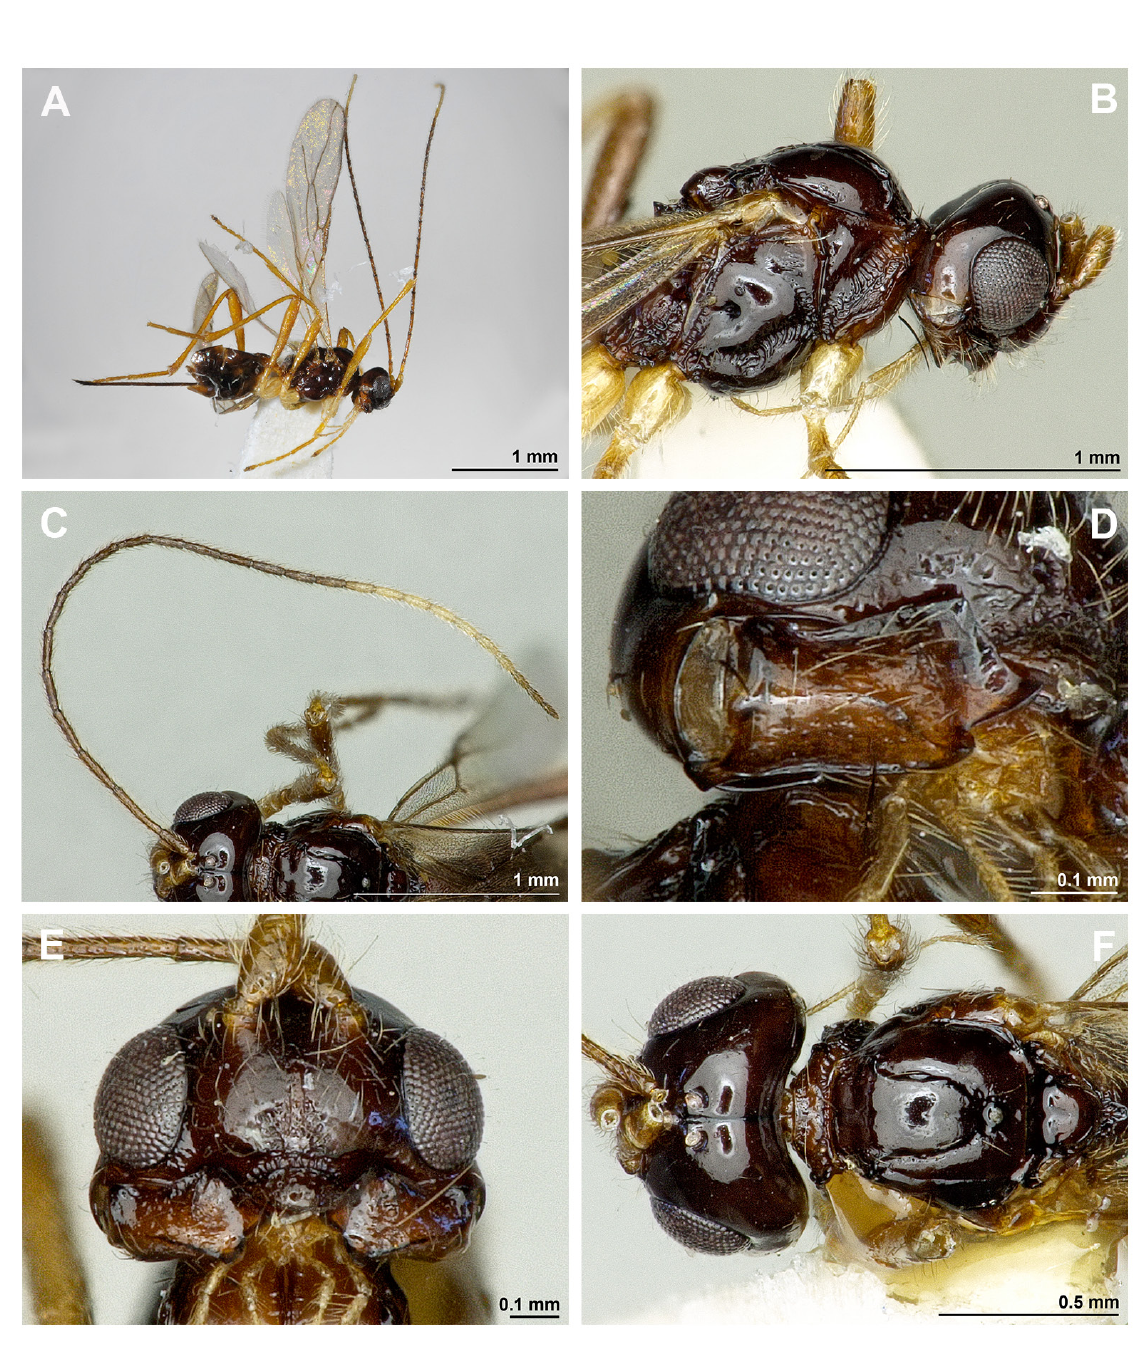
Fig. 29. Asobara kenyaensis Peris-Felipo, 2014, ♀, holotype (BMNH). A . Habitus, lateral view. B . Head and mesosoma, lateral view. C . Antenna. D . Mandible. E . Head, front view. F . Head and mesoscutum, dorsal